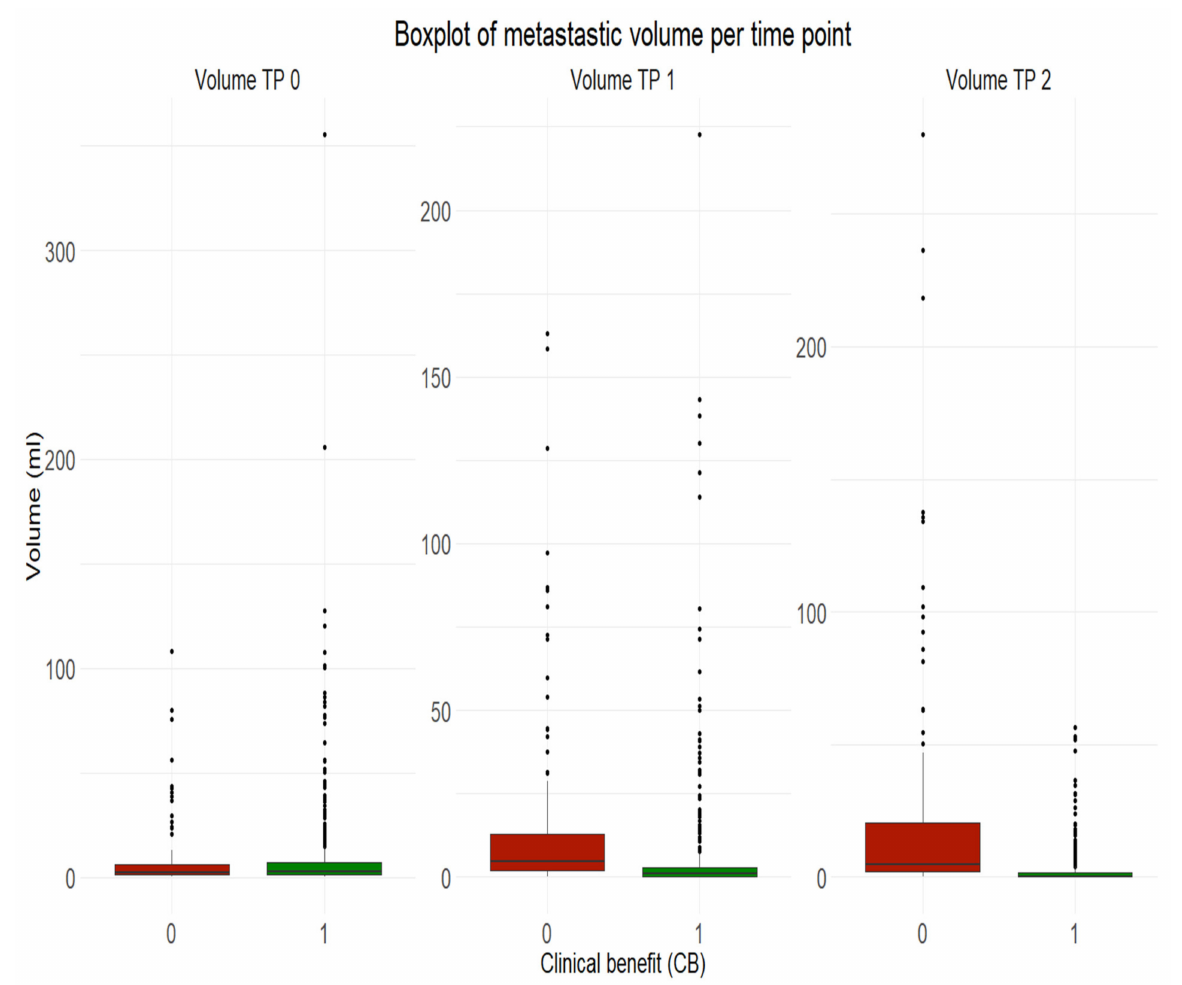
Figure 2. Boxplot of metastatic volume per time point. In green (1) non progressive melanoma metastasis with clinical benefit six months after treatment. In red (0) progressive melanoma metastasis six months after treatment. First column from left: Metastatic volume at baseline TP 0. Column in the middle: Metastatic volume three months after initiation of immunotherapy TP 1. First column from right: Metastatic volume six months after initiation of immunotherapy TP